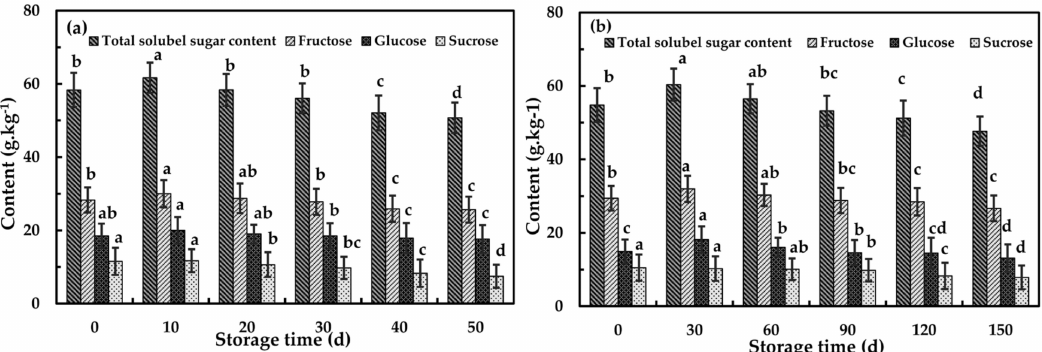
Figure 5. Soluble sugars contents of Fuji apple flesh for six storage times at 25 ◦ C ( a ) and 0 ◦ C ( b ). Columns with di ff erent letters for the same cultivar are significantly di ff erent with p < 0.05. Standard error is indicated. d,